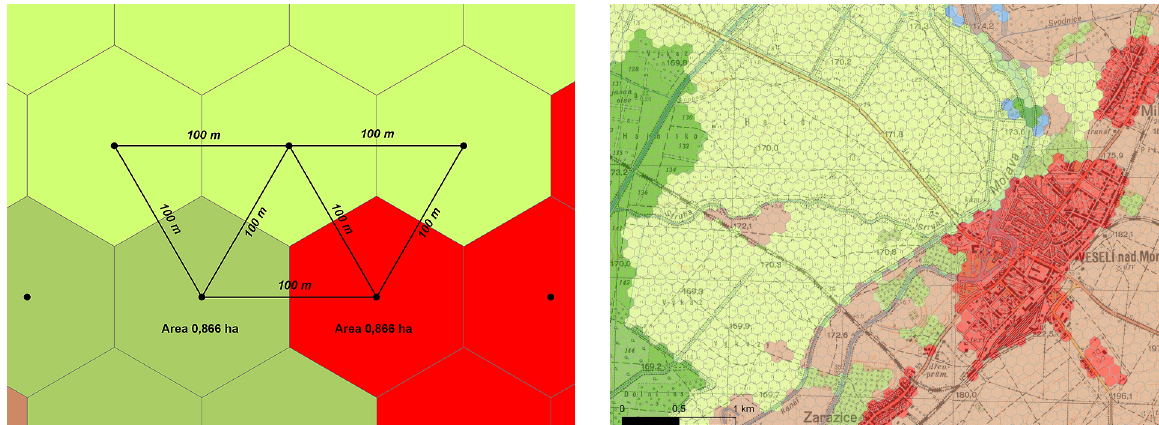
Fig. 3. Example of a hexagonal grid and the interpreted land use map from